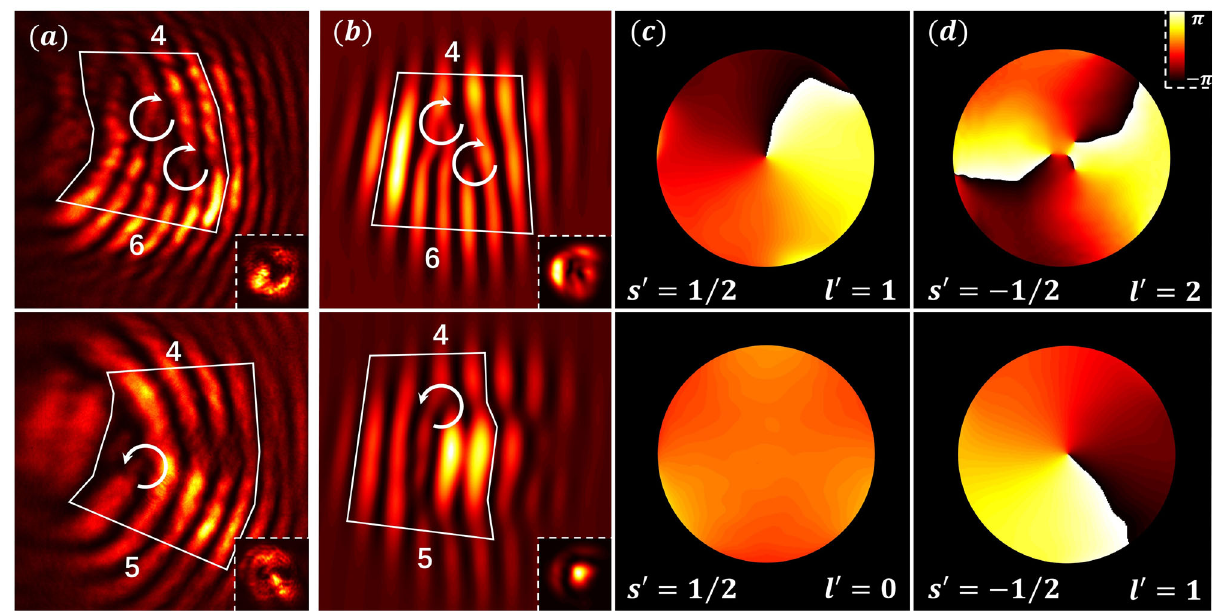
Fig. 3 Decomposed pseudospin components in an angular-momentum-conserved HCL. Top (bottom) row: pseudospin state s = 1/2 ( s = − 1/2) is selectively excited with initial beam of topological charge l = 1. a Output interferogram from the experiment, and ( b ) corresponding results from the simulation with ( c , d ) showing the evolved phase structure separately for each pseudospin component. The topological charge increases (decreases) by 1 unit in the initially unexcited component as seen in the top (bottom) panel of d ( c ), while that in the initially excited component remains intact, as governed by Eq. (3). The lower insets in ( a , b ) are the corresponding intensity patterns; the doughnut (central bright spot) pattern corresponds to l ≠ 0 ( l = 0)